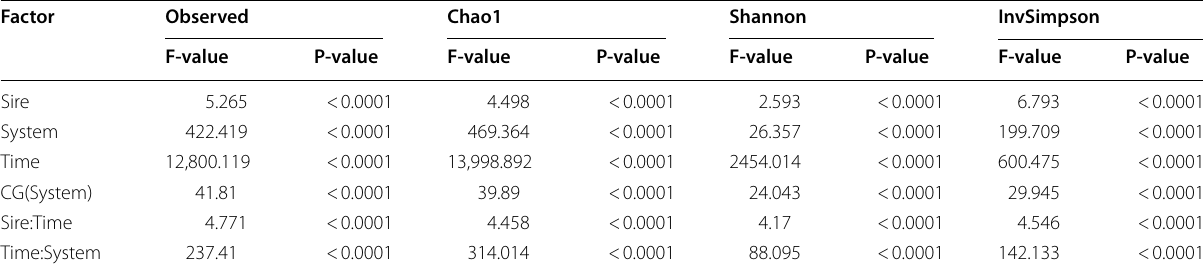
Table 1 Summary of F-value and P -value of factors that significantly affected alpha diversity in the model Factor